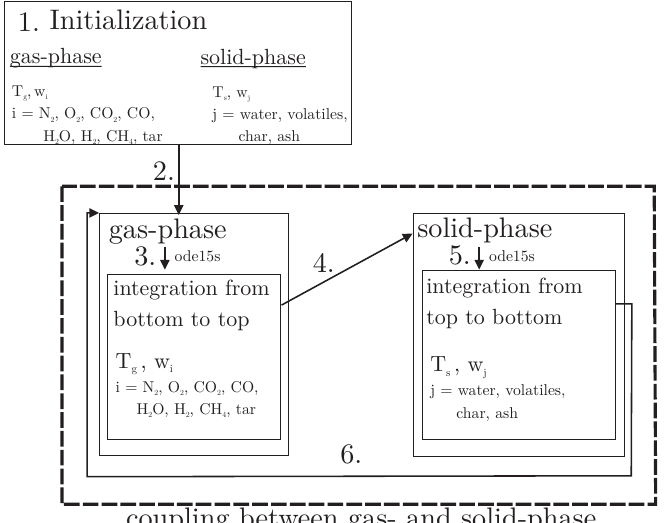
Figure 4. Solution procedure for gas-phase and solid-phase equations [20].